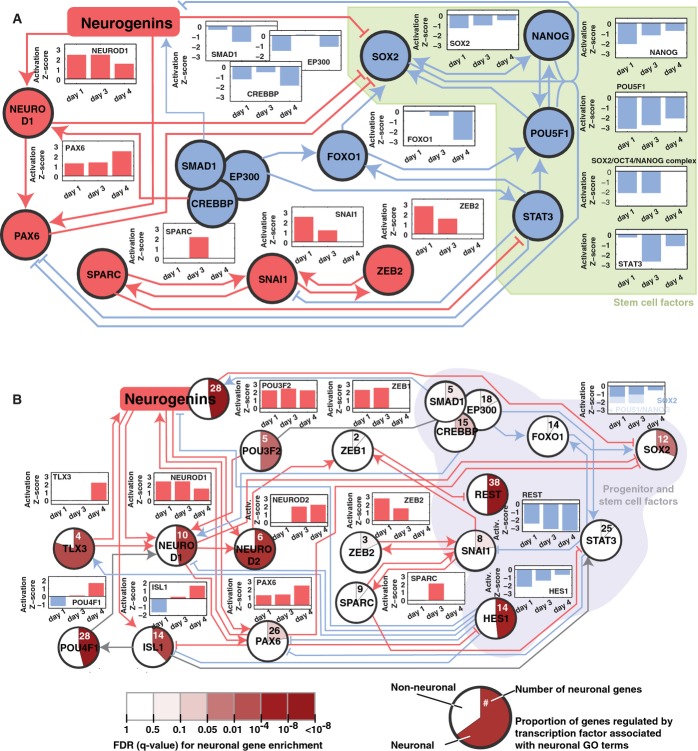
Neurogenins induce a network of transcription factors that mediate iNGN neurogenesisA network of transcription factors involved in iNGN neurogenesis was elucidated from the
transcription profiles using Ingenuity IPA (see Materials and Methods and Supplementary Fig S7).
Within this network, there is a subnetwork of transcription factors that represses stem cell
factors following Neurogenin activation. The downstream genes regulated by each transcription factor
were used to determine whether each transcription factor was activated (positive activation Z-score;
red) or inhibited (negative activation Z-score; blue), based on differential gene expression changes
seen each day (i.e., day 0 versus day 1, day 1 versus day 3, and day 3 versus day 4).Neuronal transcription factors in our network were identified by looking for a significant
overrepresentation (hypergeometric test, q < 0.05) of neuronal genes among
their known target genes (using a list of 1,295 neuronal genes based on Gene Ontology). The fraction
of neuronal gene targets for each transcription factor is shown in the pie charts, with the
significance of overrepresentation of neuronal genes shown with color intensity. A minimal
subnetwork linking all neuronal transcription factors back to the Neurogenins was identified,
showing that the Neurogenins activate proneural transcription factor cascades and suppress
transcription factors inhibiting neuronal genes.